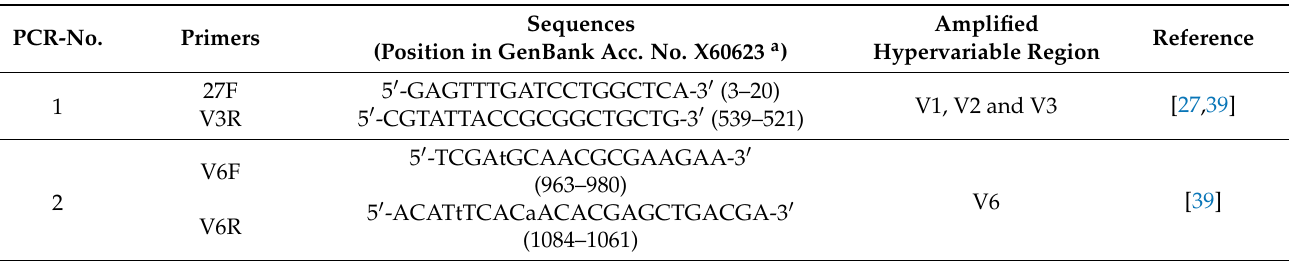
Table 2. Polymerase chain reaction (PCR) conditions of colony PCR for the adjacent sequencing of parts of the 16S rRNA-gene.